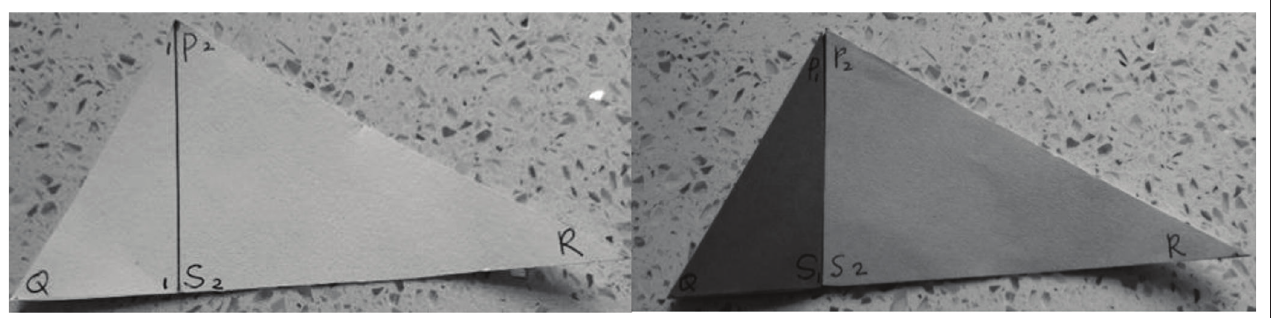
FIGURE 5: Celo’s cardboard models of the